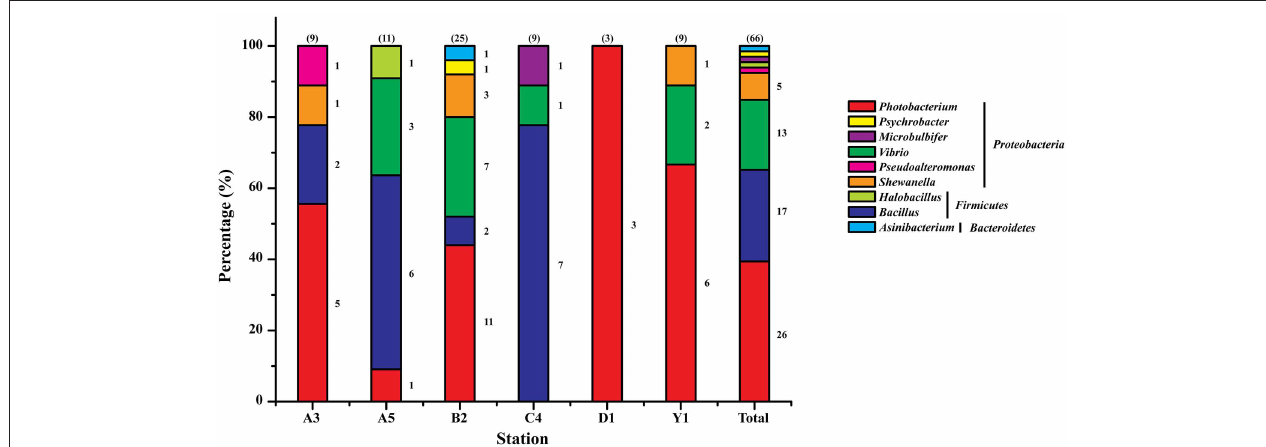
FIGURE 2 | Relative percentage abundance of the phylotypic groups of cultivable protease-producing bacteria isolated from six sampling stations in Jiaozhou Bay. The total number of strains screened from each station is shown in the parenthesis above each column. Strain numbers per genus are shown at the right of sections of the